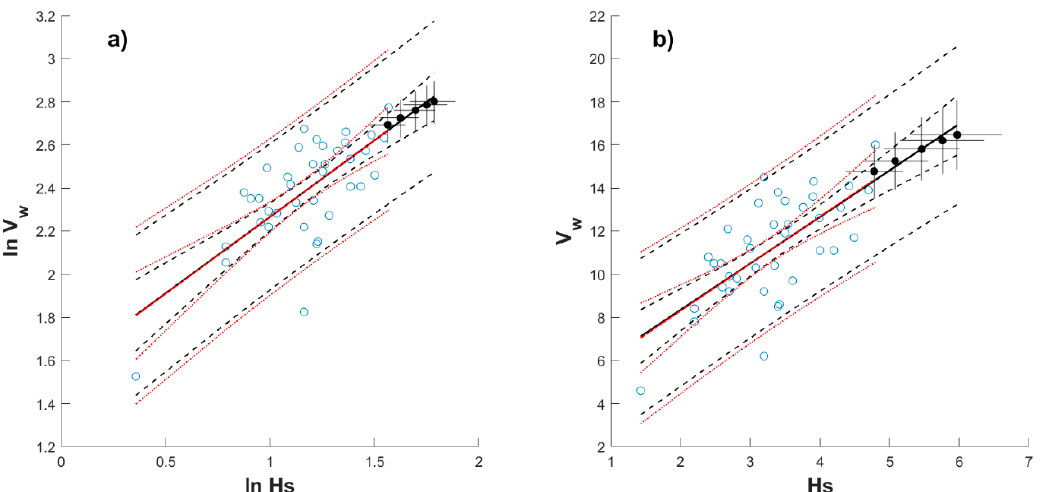
Figure A2. Regression lines and confidence intervals including (solid and dashed lines, respectively) and excluding (dashed–dotted and dotted lines, respectively) T -yr values for March; ( a ) and ( b ) for logarithmic space and linear space, respectively. Filled circles represent T -yr values with embedded perpendicular lines indicating confidence intervals from GEV models.